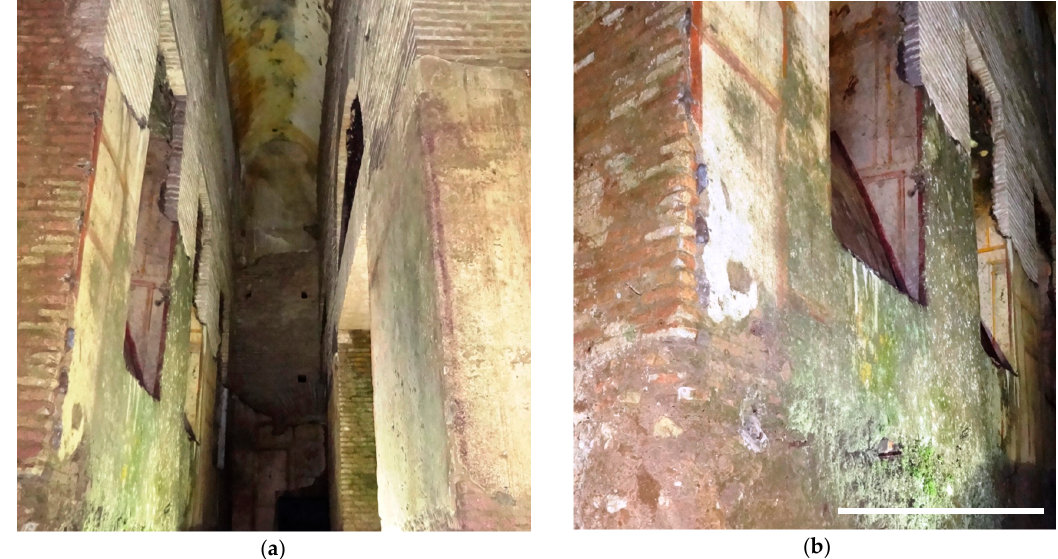
Figure 2. Two different views of the sampling site in Room 93 with the evident phototrophic biofilms causing discolouration of the walls. ( a ) front view of the corridor present in Room 93; ( b ) detailed image of the wall object of the investigation with the evident presence of the green biofilm; scale bar = 2 m.